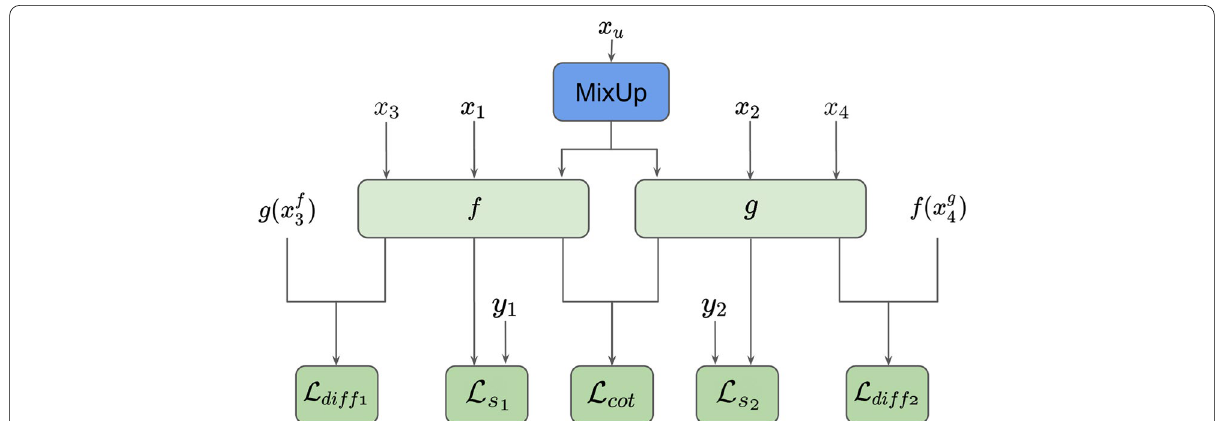
Fig. 2 DCT workflow. Each model is trained on its own labeled samples x i , unlabeled samples x u , and the adversarial examples generated by the other model. Model f makes predictions on x 1 and x g 4 , and model g on x 2 and x f 3 . In our DCT